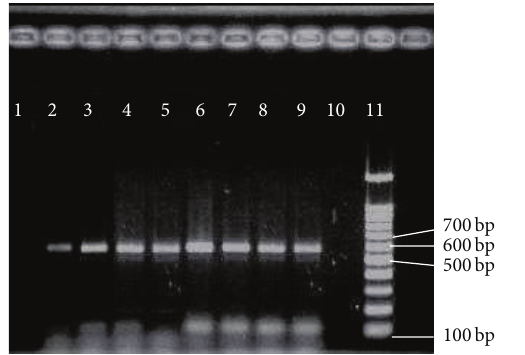
Figure 8: PCR results of hyl . 11 = marker = 100bp; 2–9 = hyl = 605 bp; 1, 10 = negative control.